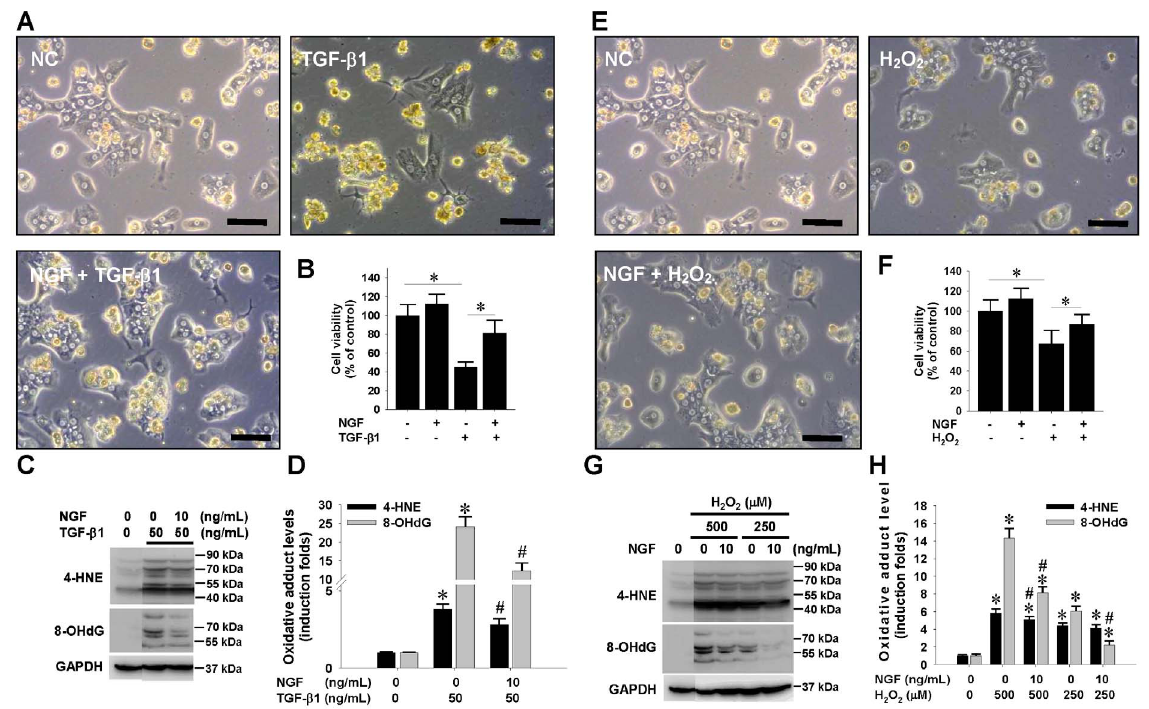
Figure 5. In vitro hepatoprotective effects of exogenous NGF supplementation on TGF- b 1-induced and oxidative cell death. Primary rat hepatocytes were treated with recombinant NGF at 20 ng/mL for 24 hrs and exposed to TGF- b 1 and H 2 O 2 for another 24 hrs, followed by morphological observation (A, E) and cell viability assay (B, F). Representative microphotographs were shown ( Bar =50 m m). Cellular viability was determined by the MTT-based viability assay. Western blots (C, G) and subsequent densitometrical analyses (D, H) show that NGF pretreatment attenuated the elevation of 4-HNE and 8-OHdG modified protein levels induced by TGF- b 1 and H 2 O 2 . Data are representative results from three independent experiments and expressed as mean 6 SD. * indicates P , 0.05, as compared between groups or with negative control. # indicates P , 0.05 compared with corresponding NGF-negative groups.